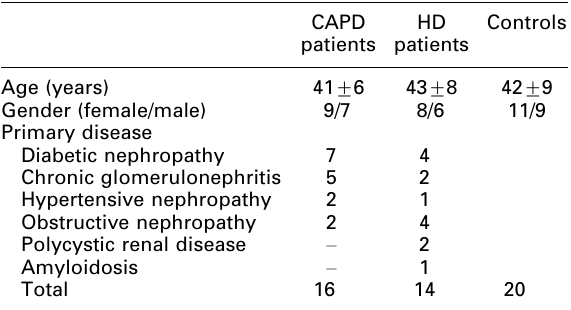
Table 1. Subject characteristics and primary diseases of the patients